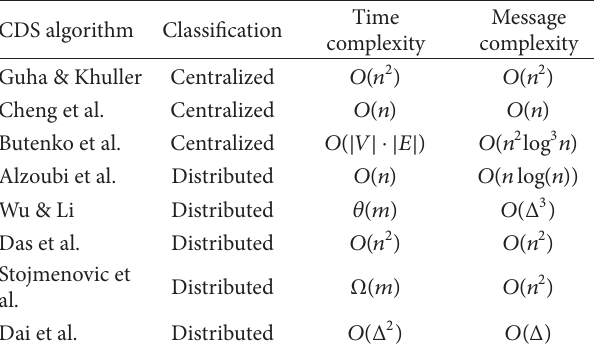
Table 1: Complexities of various CDS algorithms. CDS